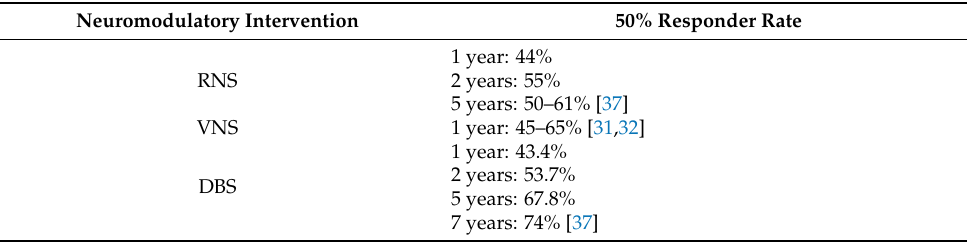
Table 1. Neuromodulatory interventions 50% responder rates. Comparison of 50% responder rates across the following neuromodulatory interventions for the treatment of epilepsy: RNS, VNS, and DBS. Neuromodulatory